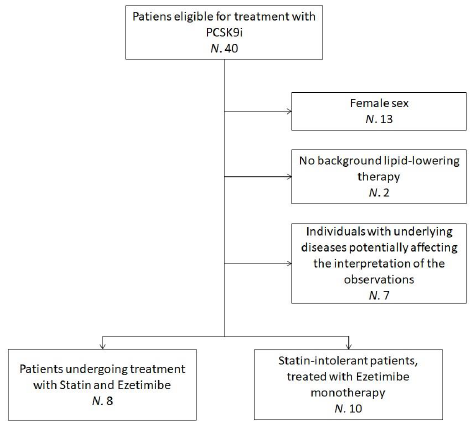
Figure 1. Flowchart detailing the recruitment process—the flowchart refers to patients clinically evaluated between March and November 2019. N = Number of individuals; PCSK9i = Protein convertase subtilisin/kexin type 9 inhibitors.